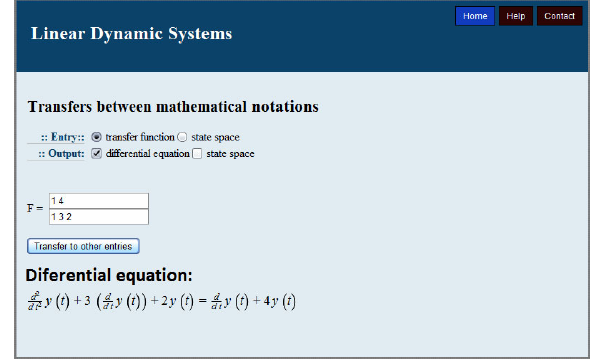
Figure 2. Front-end of the application for model